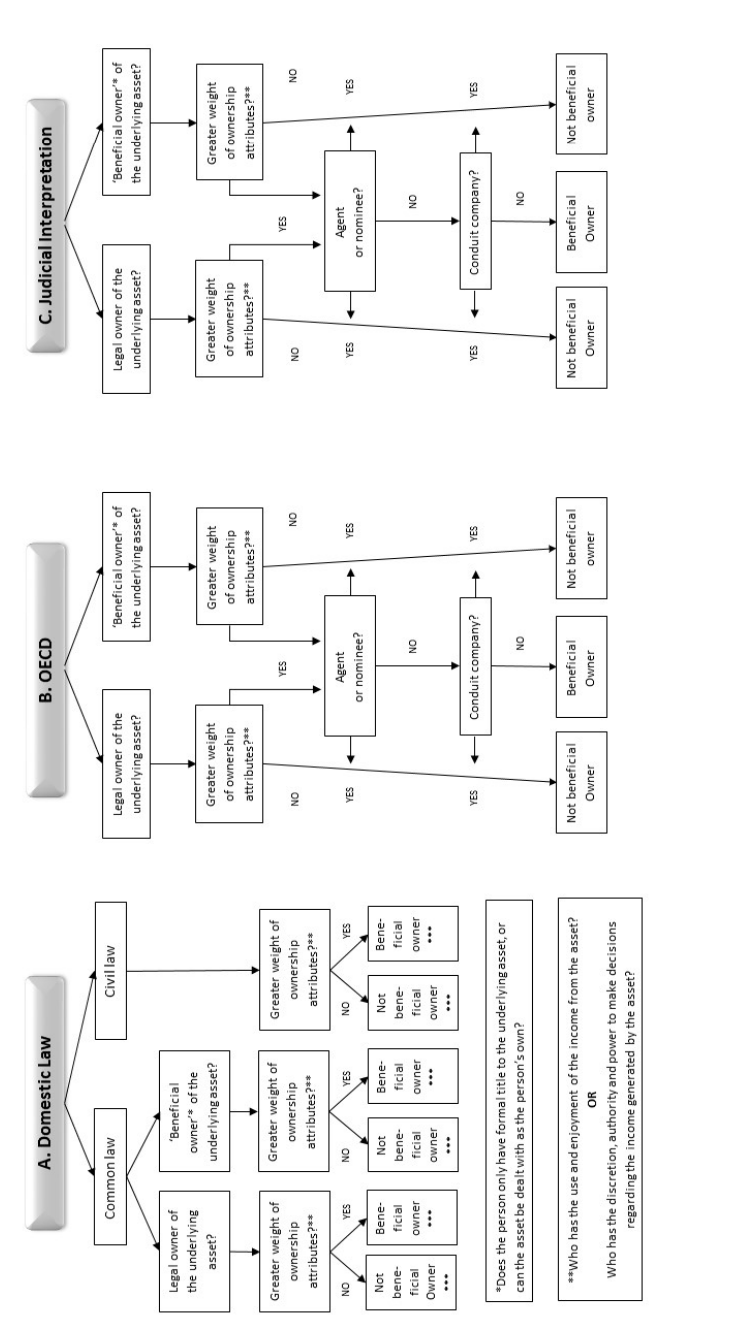
FIGURE 3: The factors in determining the beneficial owner